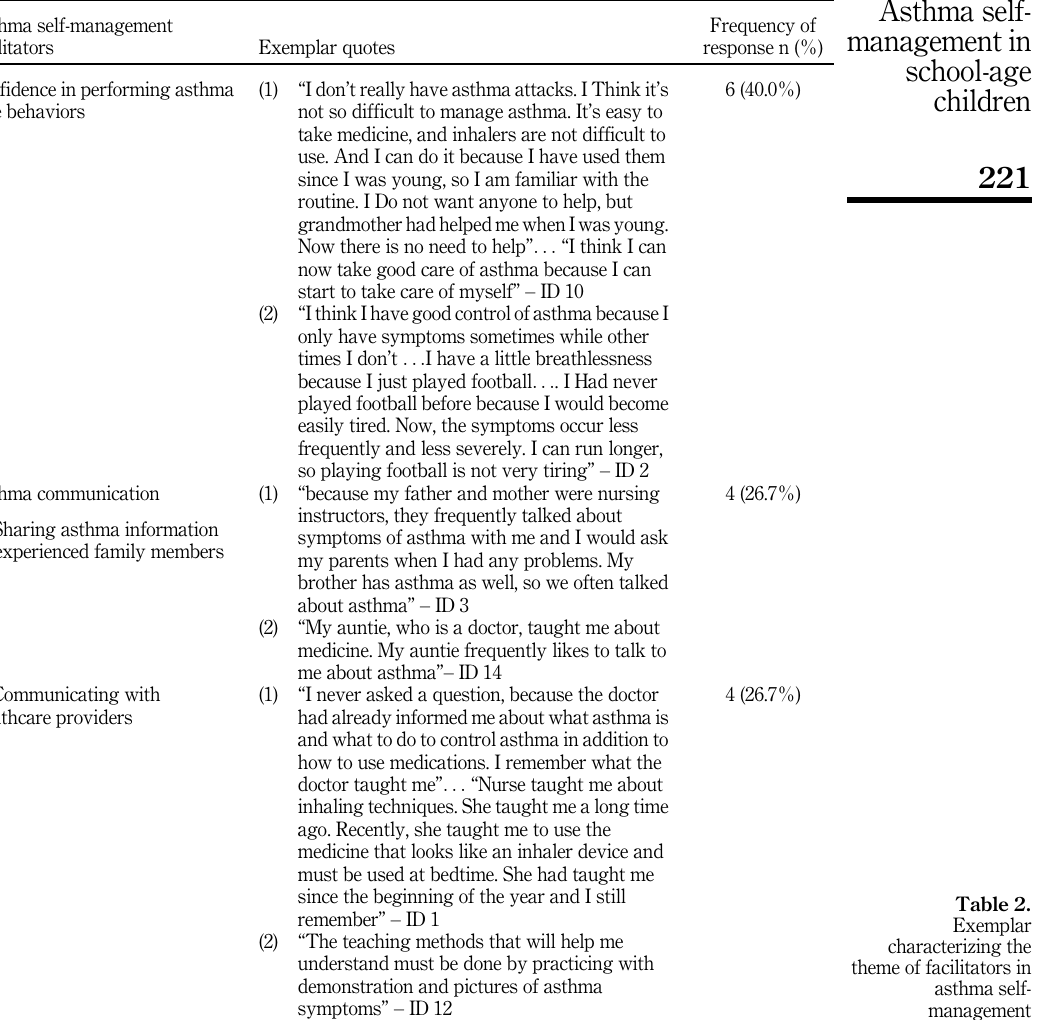
characterizing the theme of facilitators